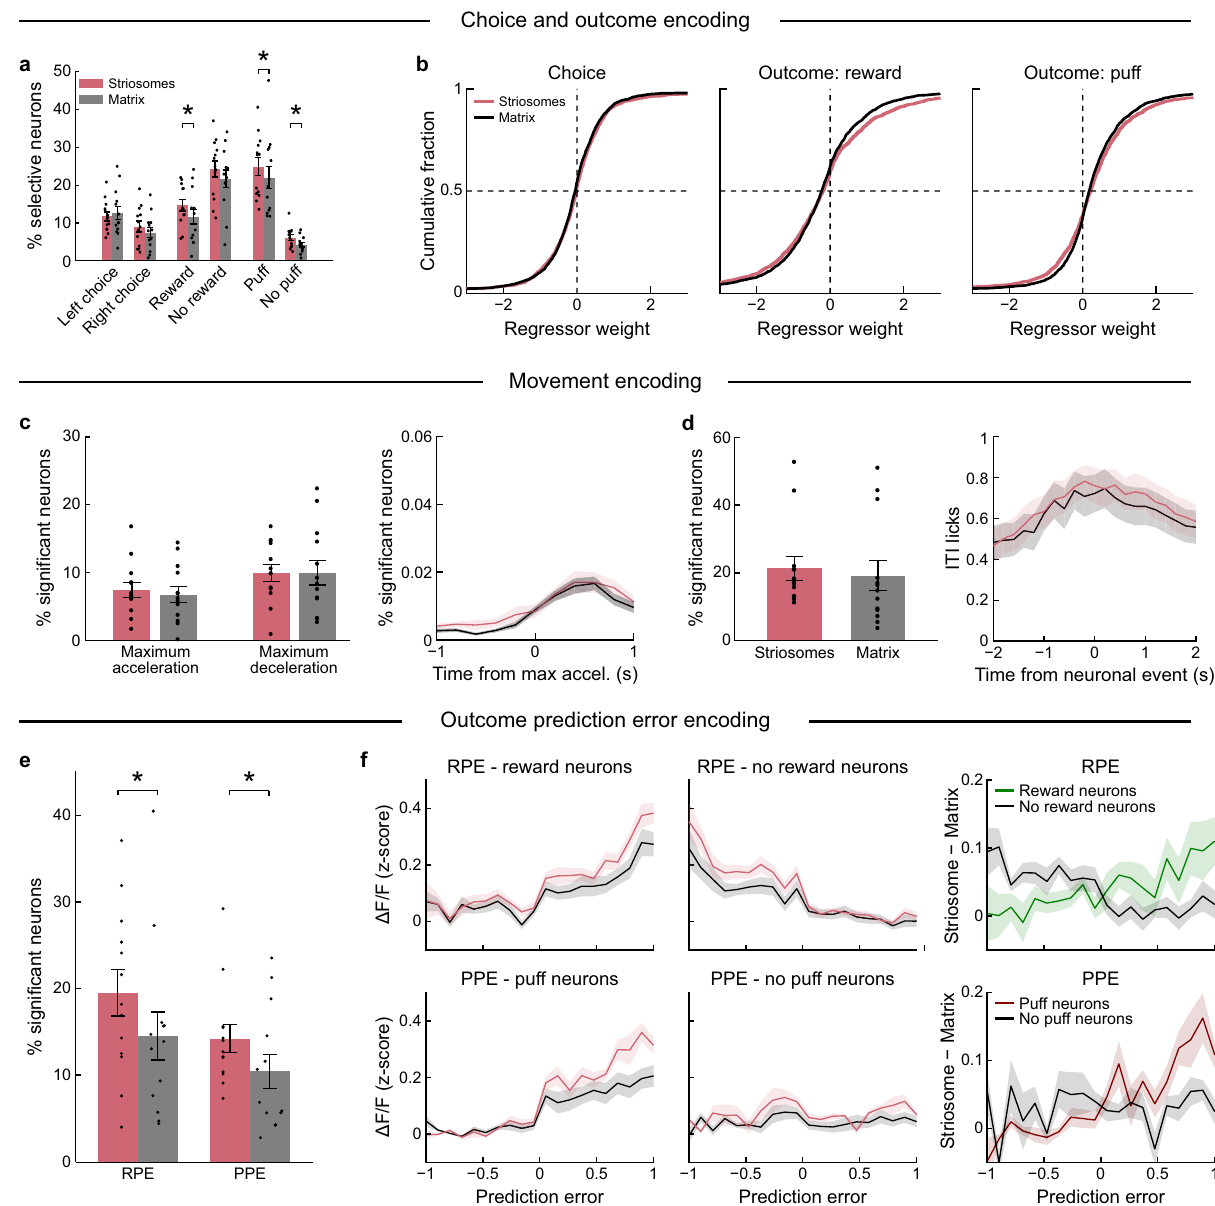
Fig. 5 Preferential outcome and PE representation for reward and punishment in striosomes. a Percentage (mean ± SEM) of neurons selective for chosen action, reward outcome or puff outcome. More sSPNs were activated by reward (sSPNs: 14.7 ± 1.4%, mSPNs: 11.7 ± 1.9%, p = 0.039, t = 2.30, df = 12, two-sided repeated measures t -test, n = 13 mice), puff (sSPNs: 24.9 ± 2.2%, mSPNs: 22.0 ± 2.8%, p = 0.046, t = 2.23, df = 12, n = 13 mice) and no-puff (sSPNs: 6.1 ± 0.7%, mSPNs: 4.2 ± 0.6%, p = 0.017, t = 2.77, df = 12, n = 13 mice) outcomes. There was a trend for no-reward neurons ( p = 0.07) and no difference for action-selective neurons. * p < 0.05. b Regression coef fi cients of sSPNs ( n = 2249) and mSPNs ( n = 3582). Their distribution was signi fi cantly different for reward ( p = 0.0044) and puff outcomes ( p = 0.0091) but not for chosen action (two-sided Kolmogorov – Smirnov test). c Neuronal activity aligned to maximum wheel acceleration and deceleration during ITIs. Percentage (mean ± SEM) of sSPNs/mSPNs with signi fi cant movement modulation (left), and average responses (mean ± SEM) of modulated neurons, aligned to peak acceleration (right; acceleration: sSPNs = 7.4 ± 1.1%, mSPNs = 6.7 ± 1.2%; n = 13 mice, two-sided unpaired t -test, p = 0.67, t = − 0.43, df = 24; deceleration: sSPNs: 9.9 ± 1.3%, mSPNs: 10.0 ± 1.8%, two-sided unpaired t -test, p = 0.99, t = 0.02, df = 24; n = 13 mice). d Licking during ITIs aligned to detected transients. Panels show percentage (mean ± SEM) of sSPNs/mSPNs with signi fi cantly more activity-triggered licking than expected by chance (left; sSPNs: 20.4 ± 3.7%, mSPNs: 18.6 ± 4.2%; n = 13 mice, two-sided unpaired t -test, p = 0.76, t = 0.31, df = 24, n = 13 mice), and licking aligned to neuronal activity (mean ± SEM) for signi fi cantly modulated neurons (right). e Percentage of sSPNs/mSPNs modulated by RPE (sSPNs: 19.5 ± 2.7% (mean ± SEM), mSPNs: 14.5 ± 2.8%, p = 0.011, t = 2.98, df = 12, two-sided repeated measures t -test, n = 13 mice) or PPE (sSPNs: 14.2 ± 1.6, mSPNs: 10.4 ± 1.9%, p = 0.039, t = 2.32, df = 12, n = 13 mice) in the stepwise regression model. * p < 0.05. f RPE/PPE modulation of Δ F / F in reward- or puff-selective sSPNs/mSPNs. Correlation coef fi cients were higher for sSPNs than for mSPNs (reward: p = 0.042; puff: p = 0.0089, n = 13 mice, two-sided repeated measures t -test). Right: the difference between the modulation in the sSPNs and mSPNs was correlated with RPE/PPE in reward ( r = 0.77; p < 0.01, n = 13 mice, Pearson correlation) and puff ( r = 0.72; p < 0.05, n = 13 mice) neurons, respectively. Data shown represent mean ± SEM. Source data are provided as a Source Data fi